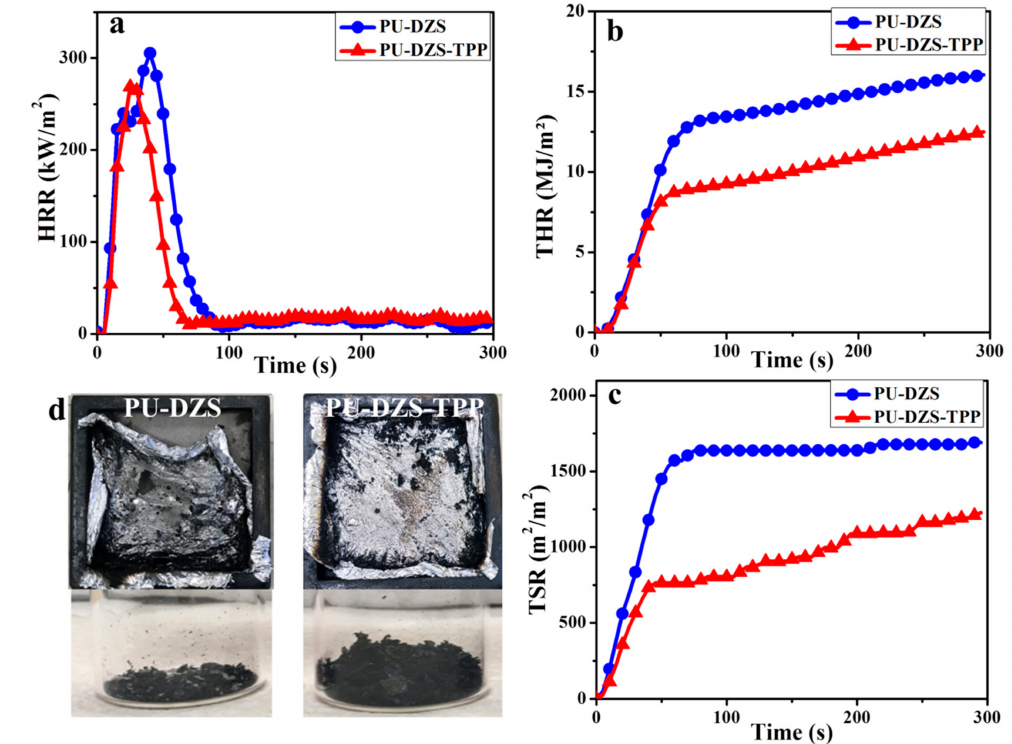
Figure 10. ( a ) HRR; ( b ) THR; and ( c ) TSR data and ( d ) the digital photos of the residual char after cone calorimeter tests of PU-DZS and PU-DZS-TPP 25